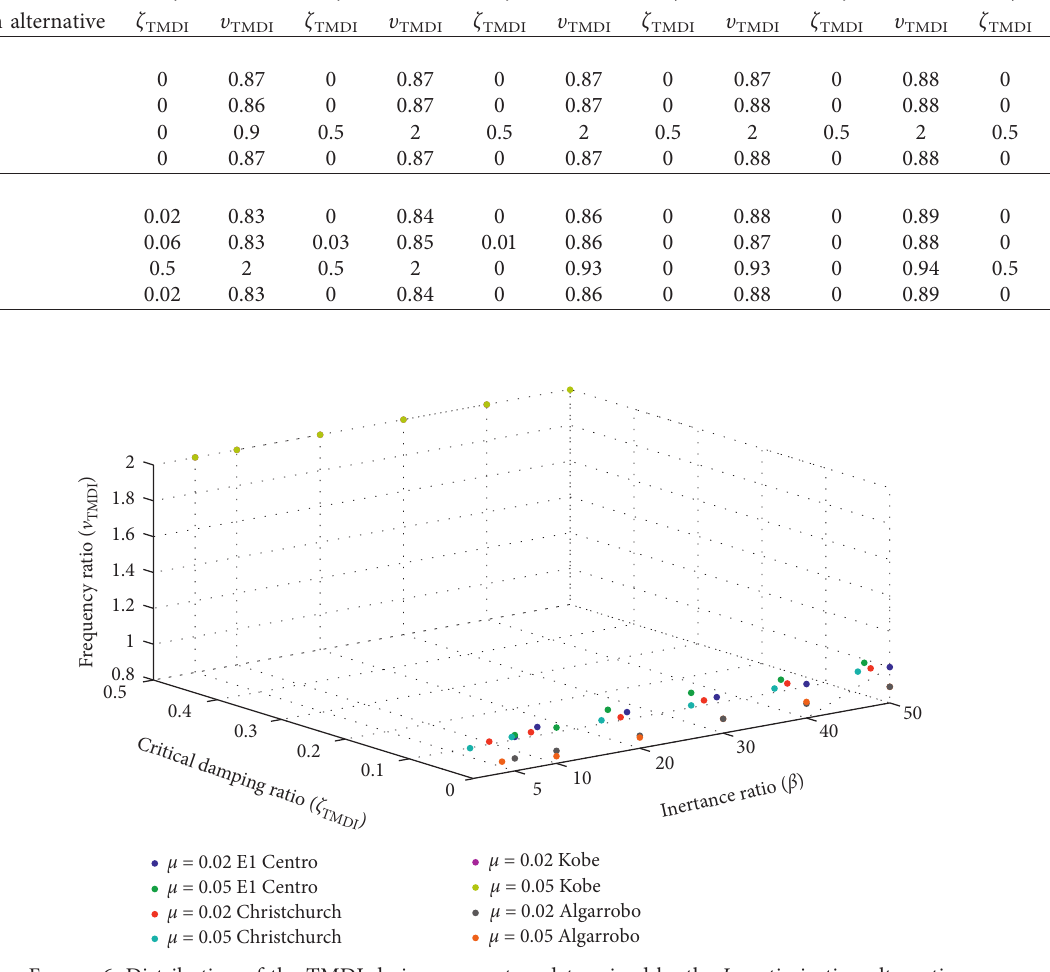
P optimization alternative.